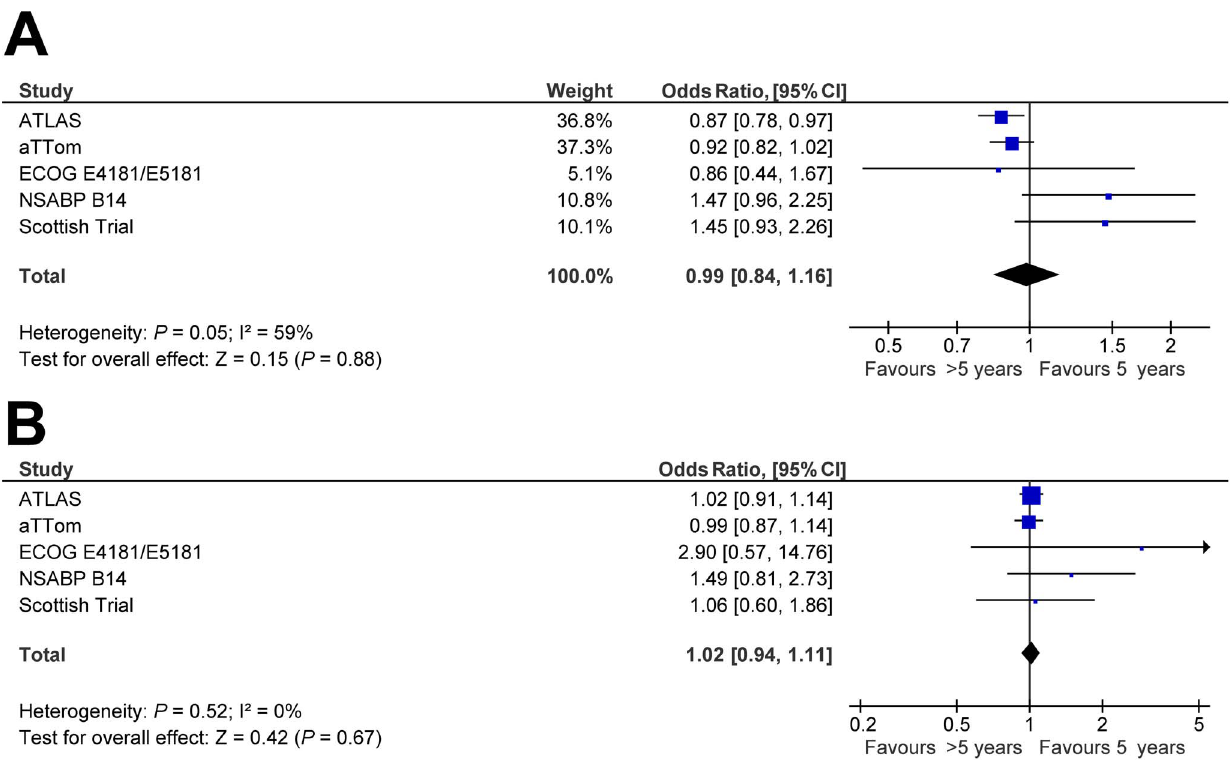
Figure 5. Forest plots of odds ratios for (A) all-cause death and (B) death without recurrence for patients treated with extended adjuvant tamoxifen ( . 5 years) versus adjuvant tamoxifen (5 years) based on primary analysis of individual trials. Odds ratios for each trial are represented by the squares , the size of the square represents the weight of the trial in the meta-analysis, and the horizontal line crossing the square represents the 95% confidence interval. The diamonds represent the estimated pooled effect based for each cohort individually (labeled subtotal) and for all cohorts together (labeled total).